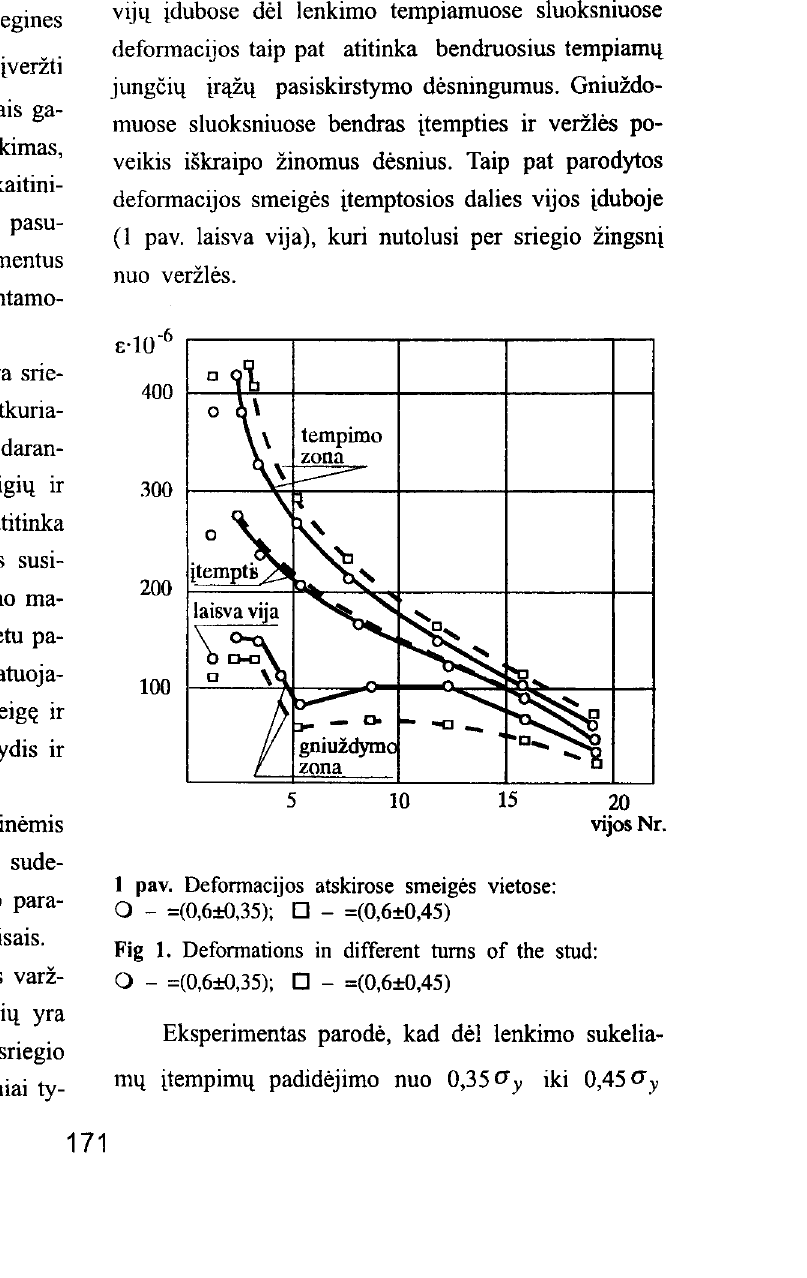
Fig 1. Deformations in different turns of the